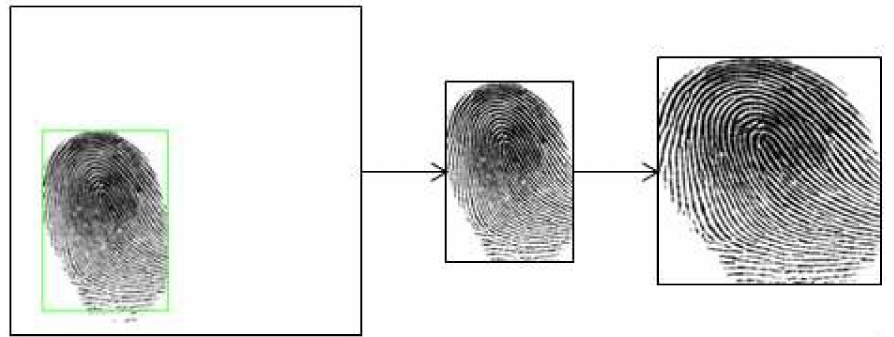
Figure 6. Steps of preprocessing. The original fingerprint image is from Crossmatch in LivDet 2015. Region of Interest (ROI) extraction is firstly applied to obtain the fingerprint foreground region and then resize the